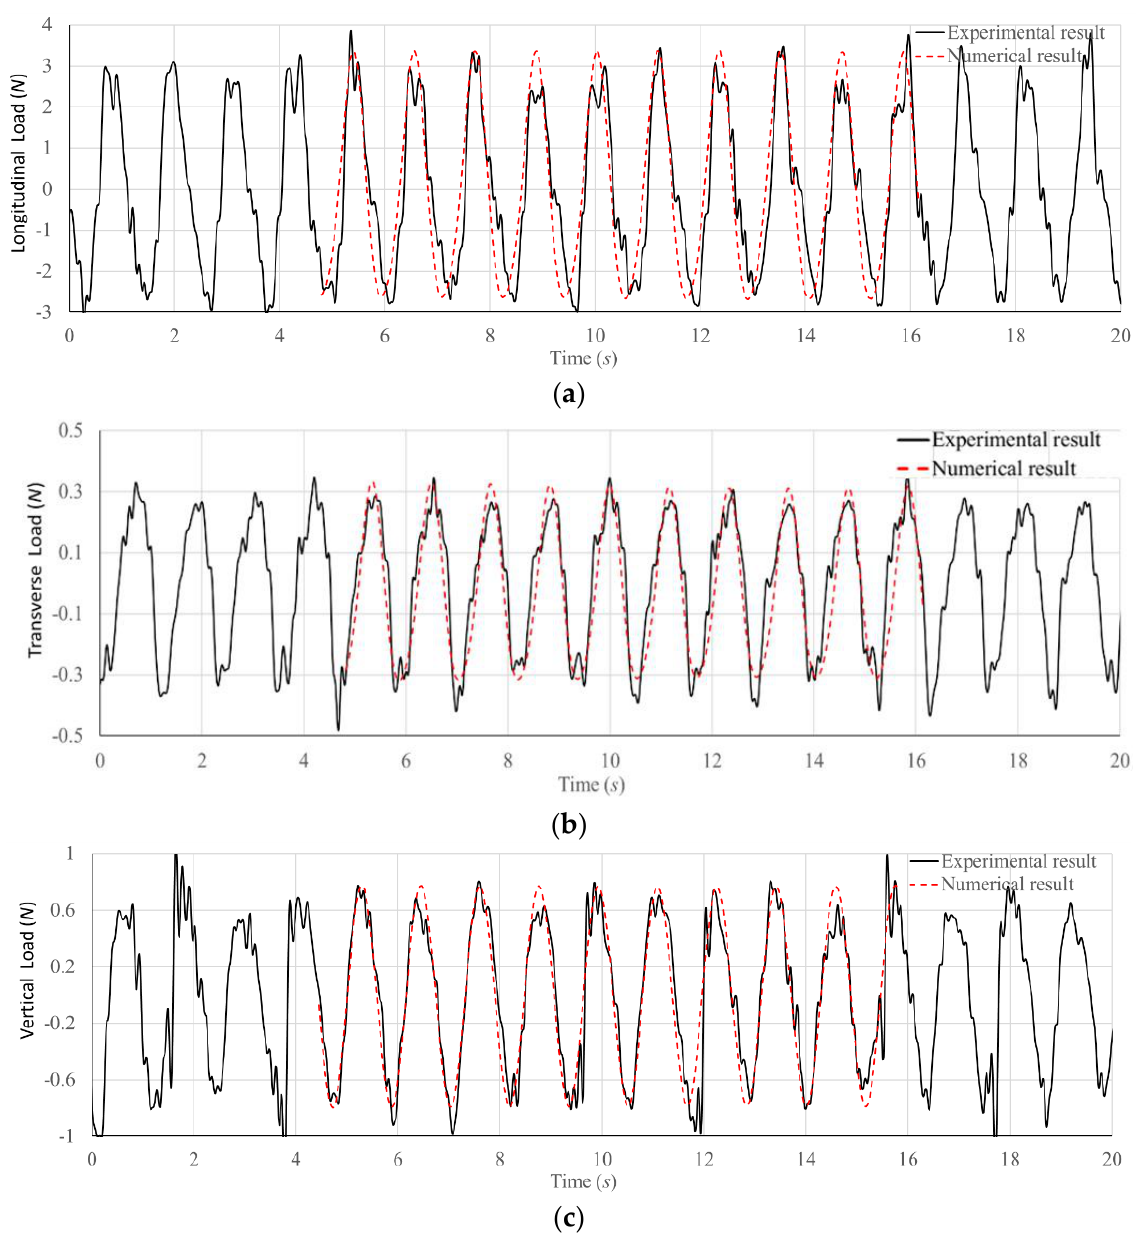
Figure 13. The load time history in condition direction − 3: ( a ) longitudinal load; ( b ) transverse load; ( c ) vertical load.